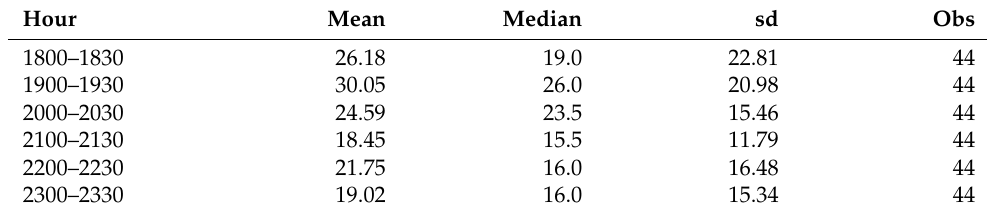
Figure A1. Number of captures for given time period. Table A2. Basic Statistics by Table A2. Basic Statistics by Hour .